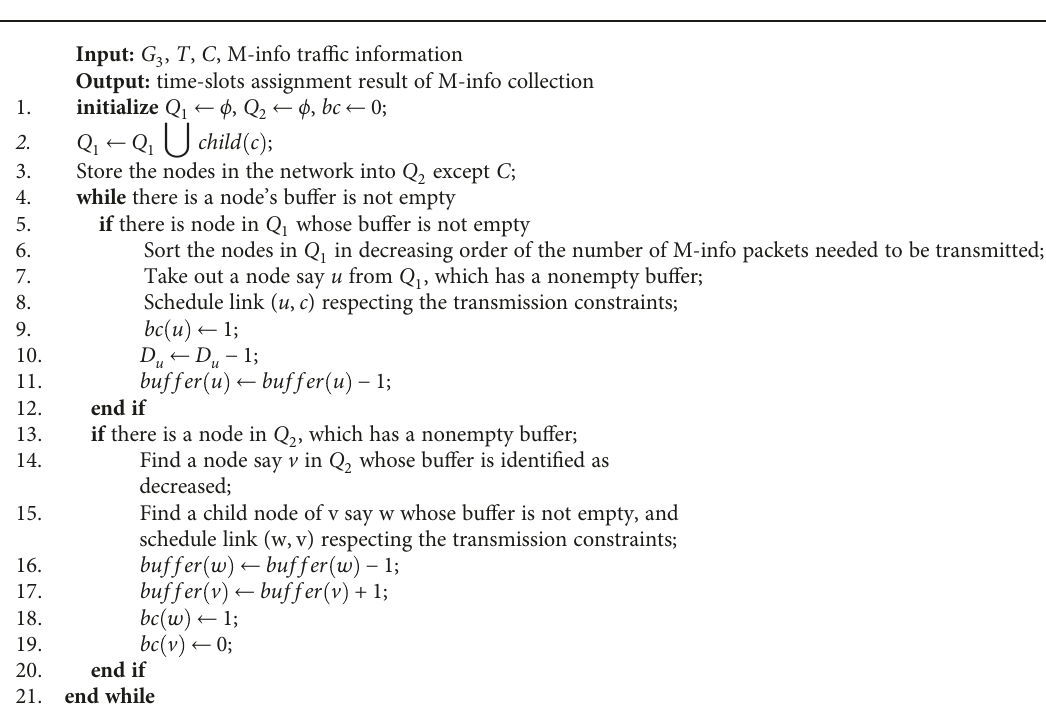
Algorithm 6: Bu ff er change-based time slot